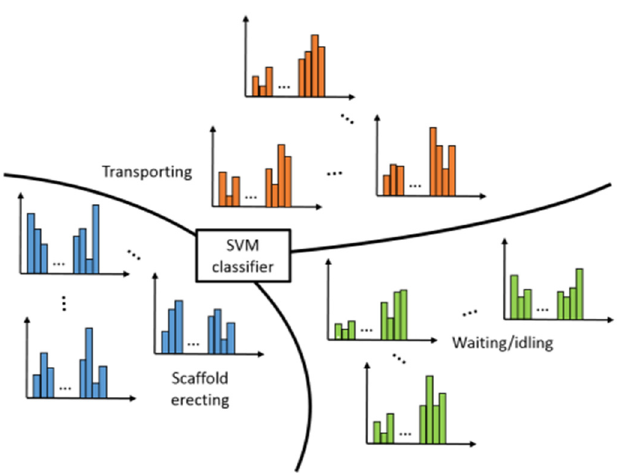
Figure 8. SVM classifier (It looks for a group of hyperplanes to classify data points or vectors). Artificial Neural Networks (ANN). ANN were inspired by the mechanism and structure of biological neural networks in a human’s brain in that the signals are received, transmitted and emitted back and forth through multiple layers of neurons. The basic